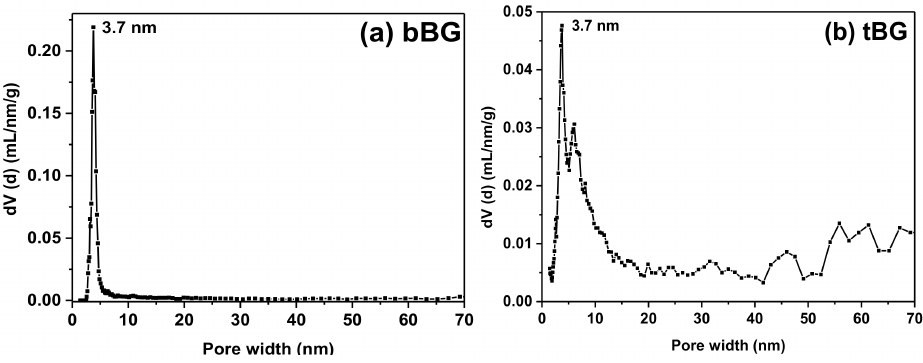
Figure 5. Pore size distribution curves of ( a ) bBG and ( b )